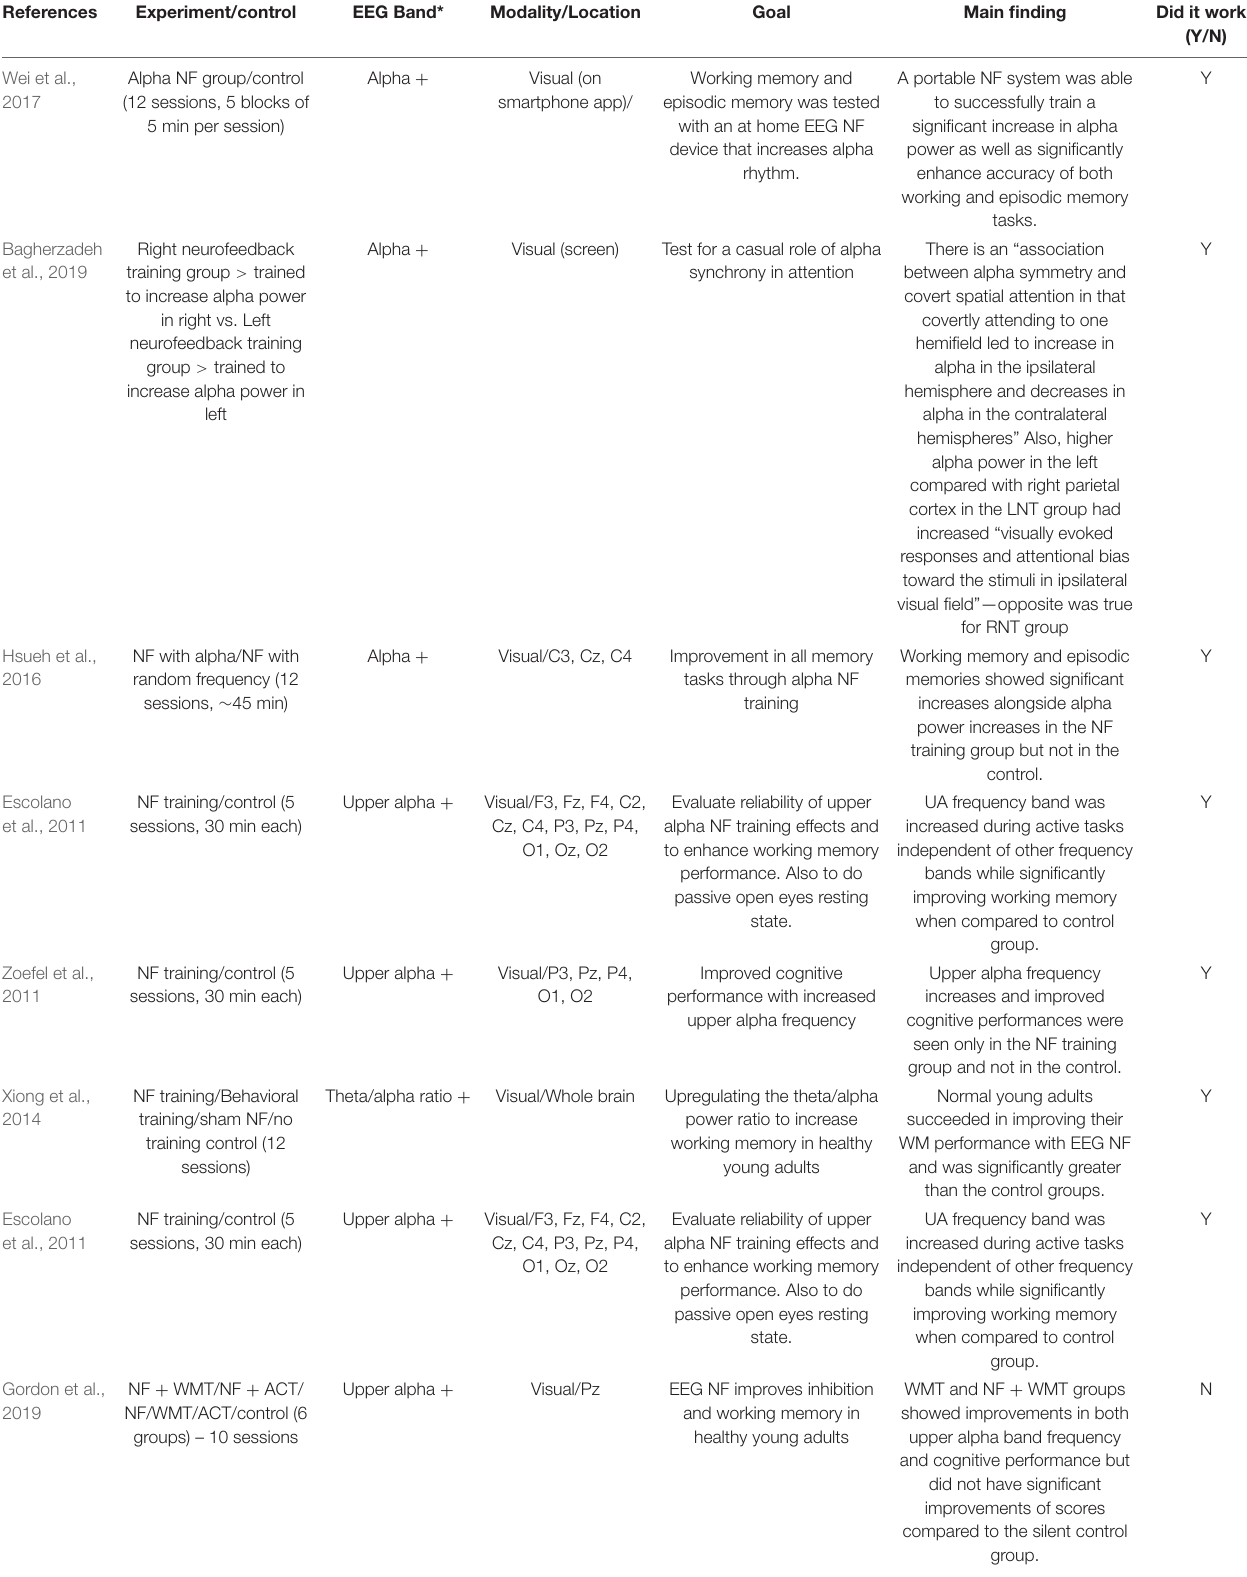
TABLE 2 | Sample NF training in young adults with or without